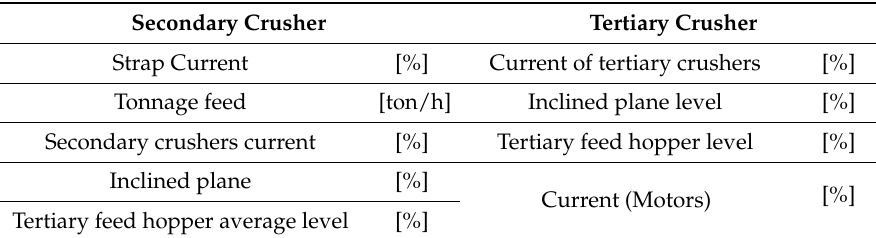
Table 1. Critical Variables for Expert System, Crushing